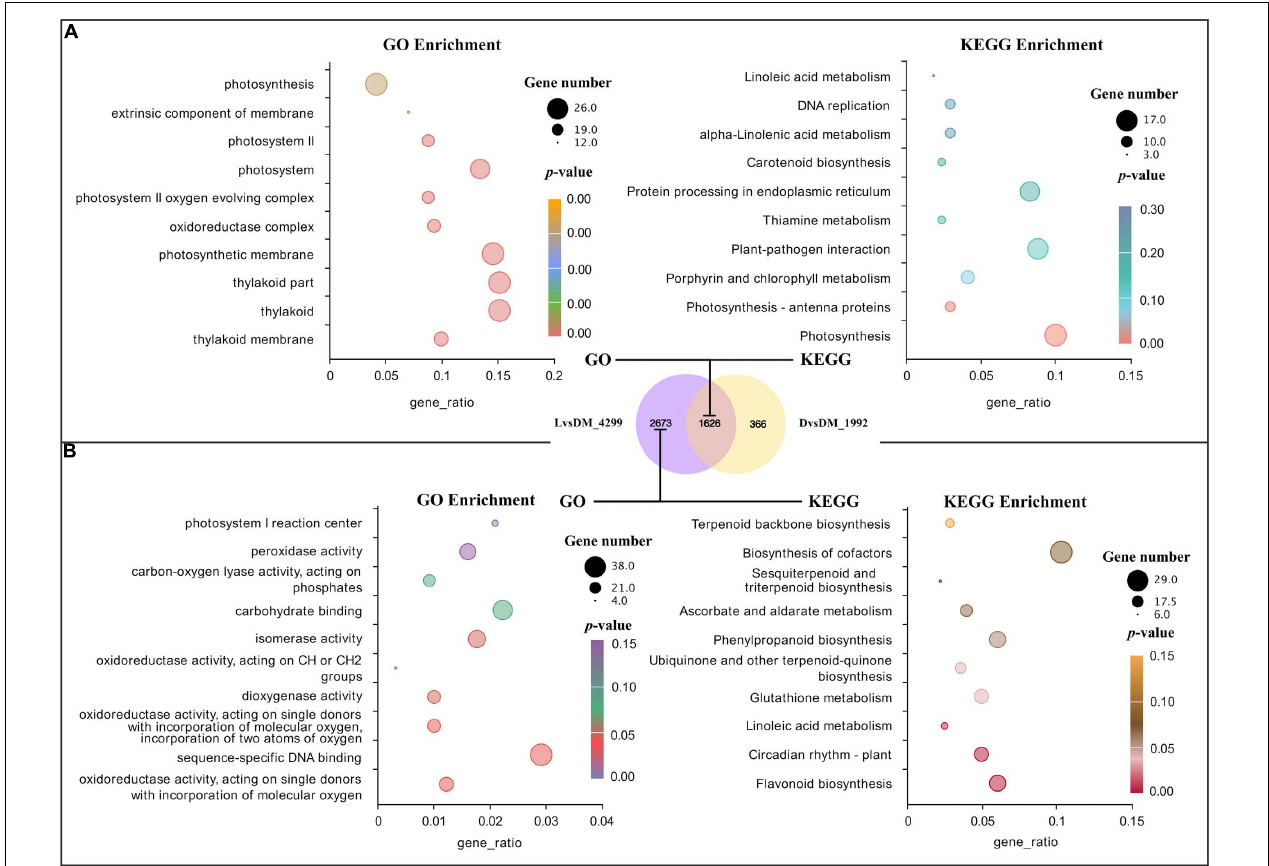
FIGURE 2 | GO and KEGG analysis for DEGs shared by D vs. DM and L vs. DM and found only in L vs. DM. (A) Significant GO terms and KEGG pathways for DEGs shared by D vs. DM and L vs. DM; (B) significant GO terms and KEGG pathways for DEGs found only in L vs. DM. The “gene_ratio” means the ratio of the number of DEGs annotated in the KEGG pathway to the total number of DEGs that can be annotated in the KEGG database.